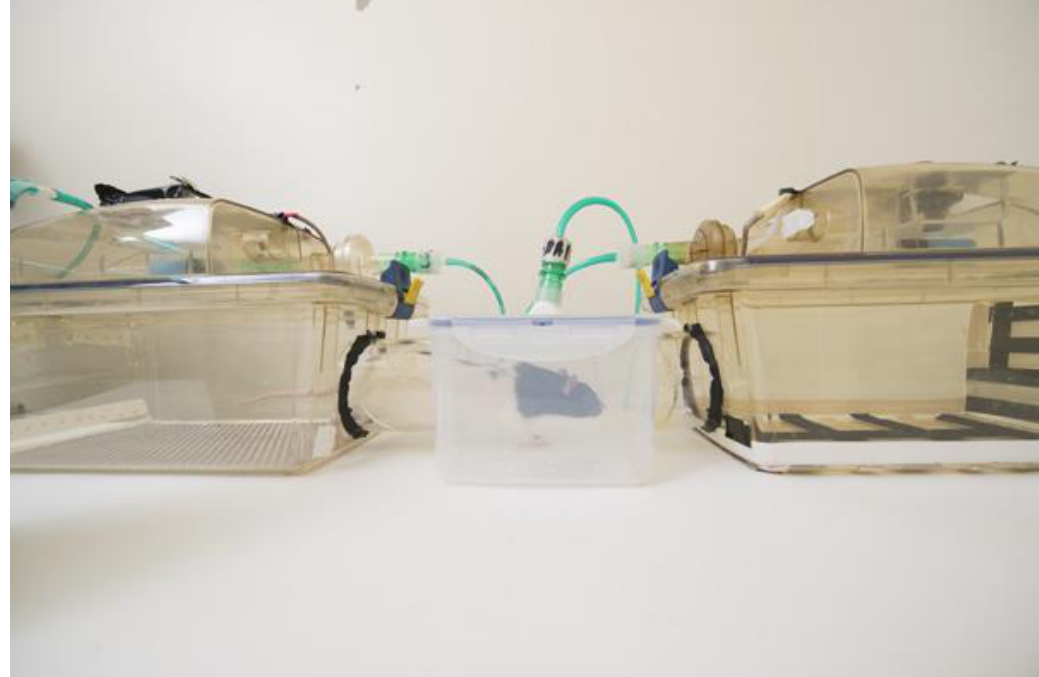
Figure 3. Example of apparatus for conditioned place preference/aversion paradigm. The right and left cage compartments have differently patterned and textured floors and walls to ensure the animal can discriminate between them.